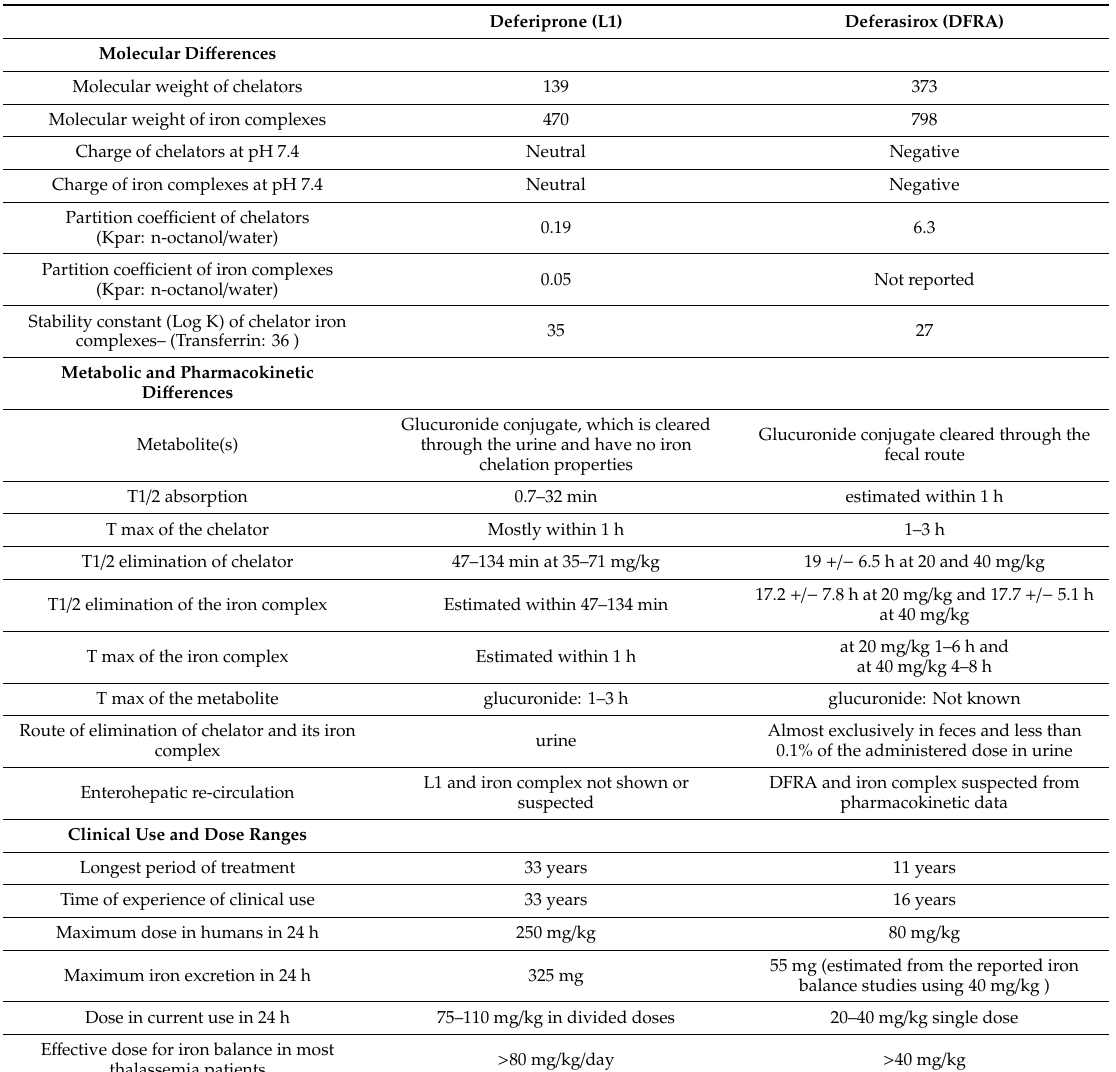
Table 6. Molecular and pharmacological di ff erences between deferiprone and